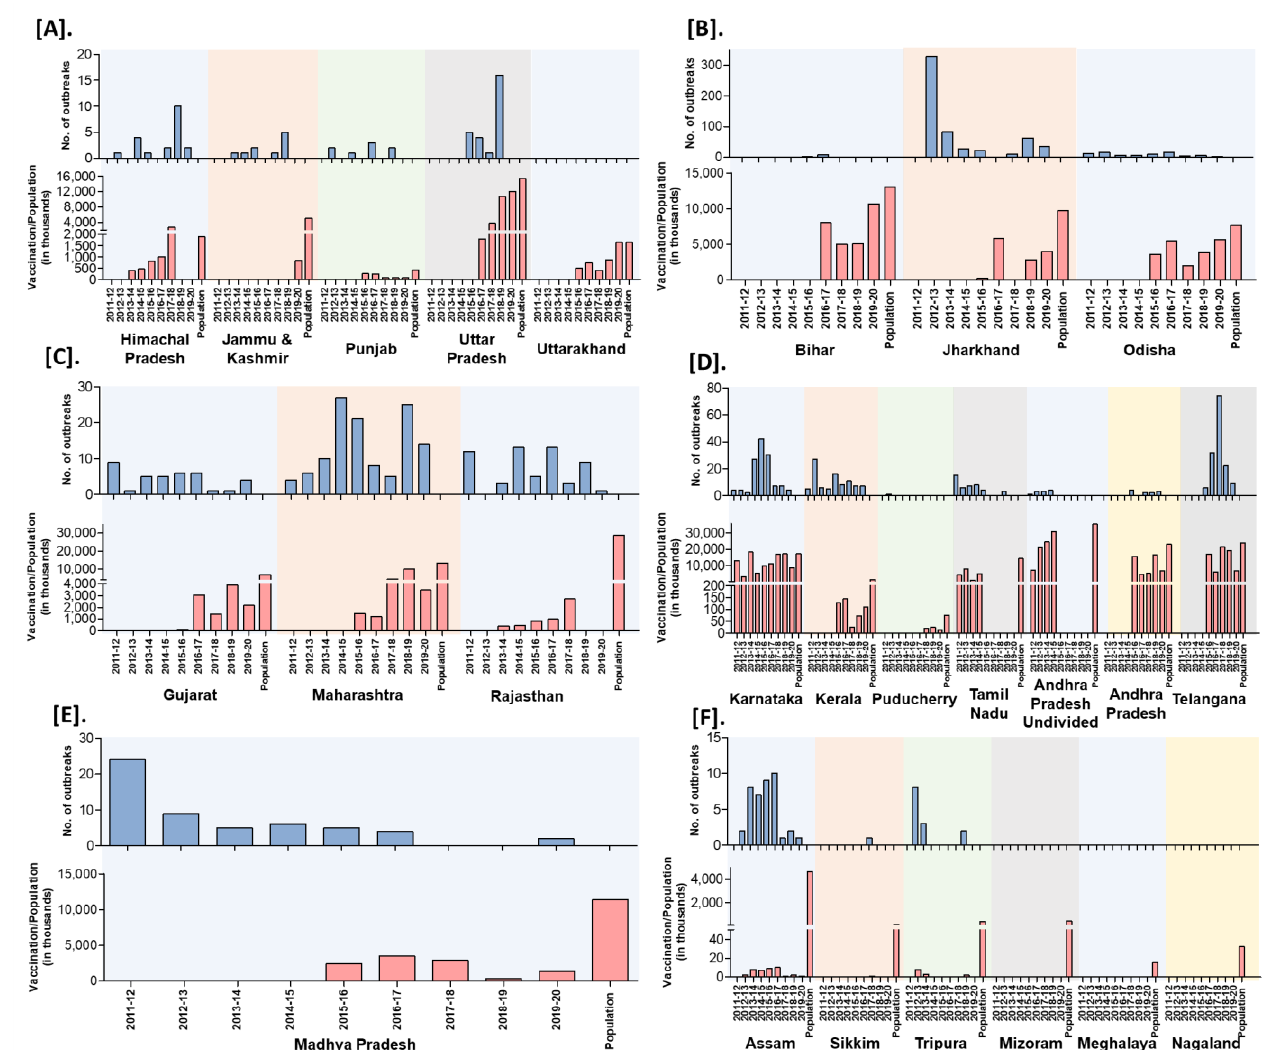
Figure 10. Zone-wise trend of outbreaks reports in the states from the financial year 2011-12 to 2019–2020; outbreak reports versus the doses of vaccines used (in thousand) in the strategic immunizations during the preceding years against the population are depicted. ( A ). North ( B ). East ( C ). West ( D ). South ( E ). Central ( F ). North-East zones.